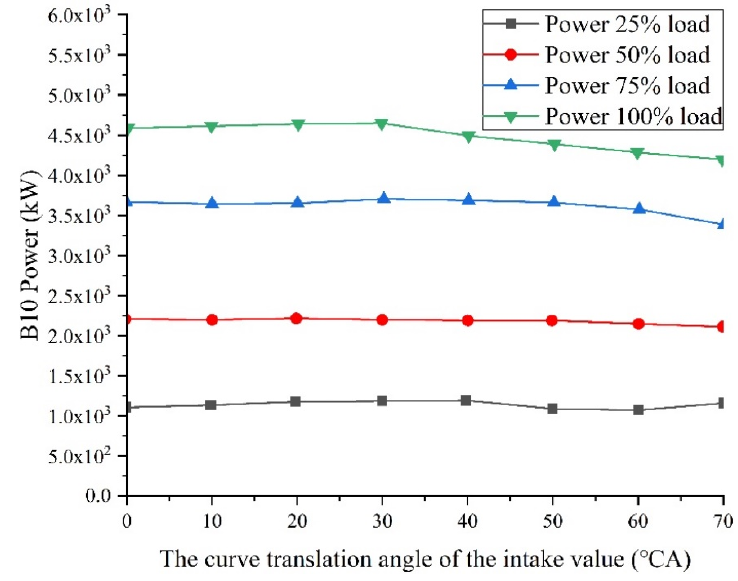
Figure 10. The NO x emission comparison.